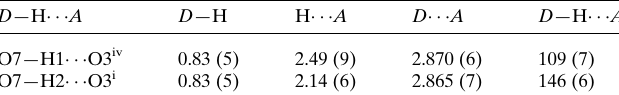
Table 2 Hydrogen-bond geometry (A˚ , (cid:3) ).